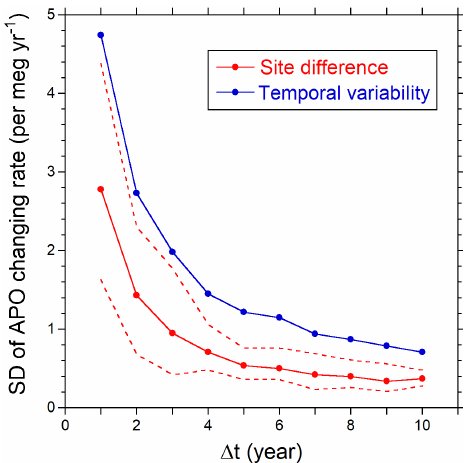
Figure 7. Relationship between the standard deviation (SD) of the APO changing rate and the time interval to calculate the changing rate. The red circles represent the averages of the standard devi- ations of the APO changing rates from the different sites for the same year. The dashed lines represent the minimum and maximum of the standard deviations. The blue circles represent the temporal variability in the average APO changing rate of the different